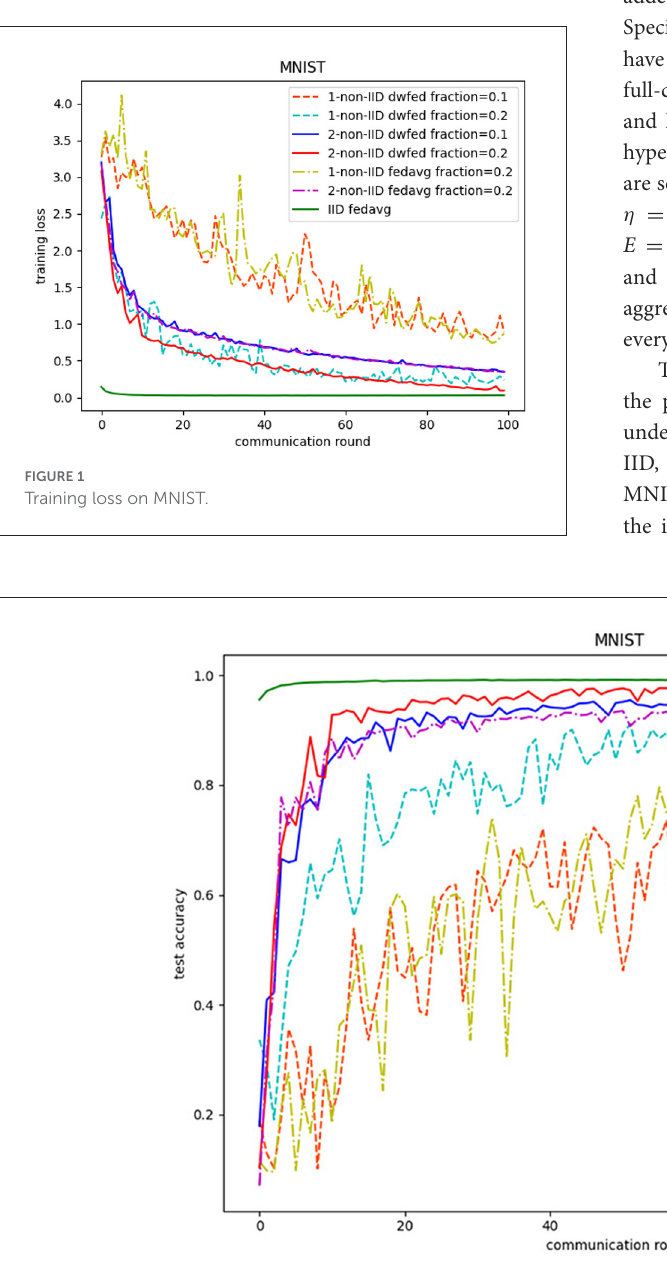
FIGURE2 Test accuracy on